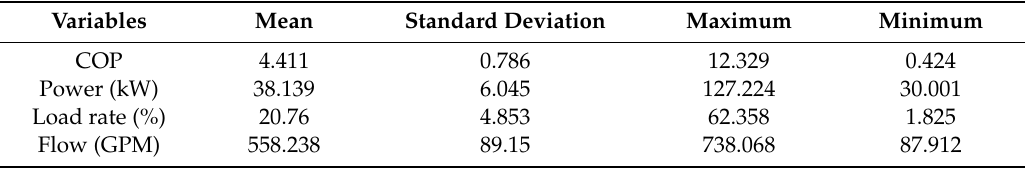
Table 2. Descriptive statistics of the key variables of chiller